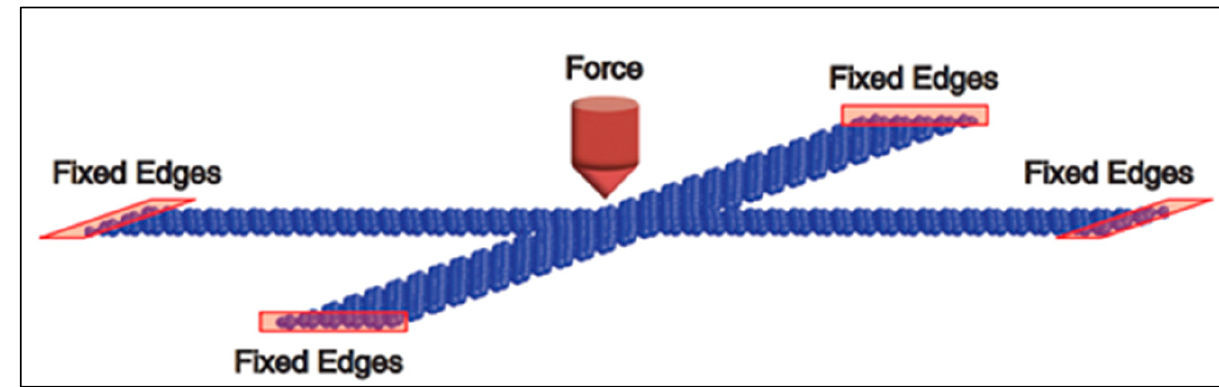
Figure 1. Prototype of a graphene resonator.